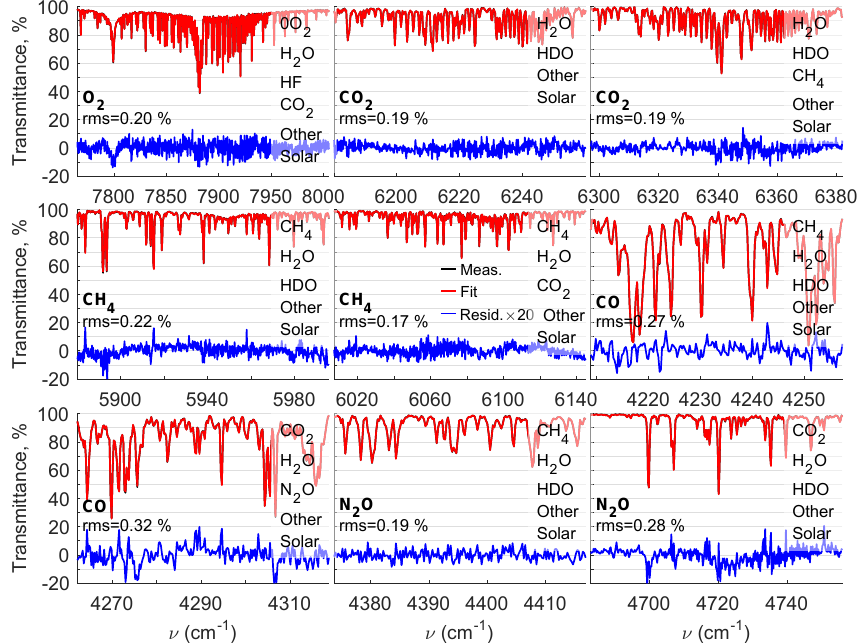
Figure 7. Example spectral fits and residuals ( × 20) from several of the retrieval windows from 28 June 2014, 10:55:16 (UTC − 8), SZA = 17.1 ◦ . The primary species of interest and root mean square (rms) of the residuals are listed on the left. Other species fit in the window are listed on the